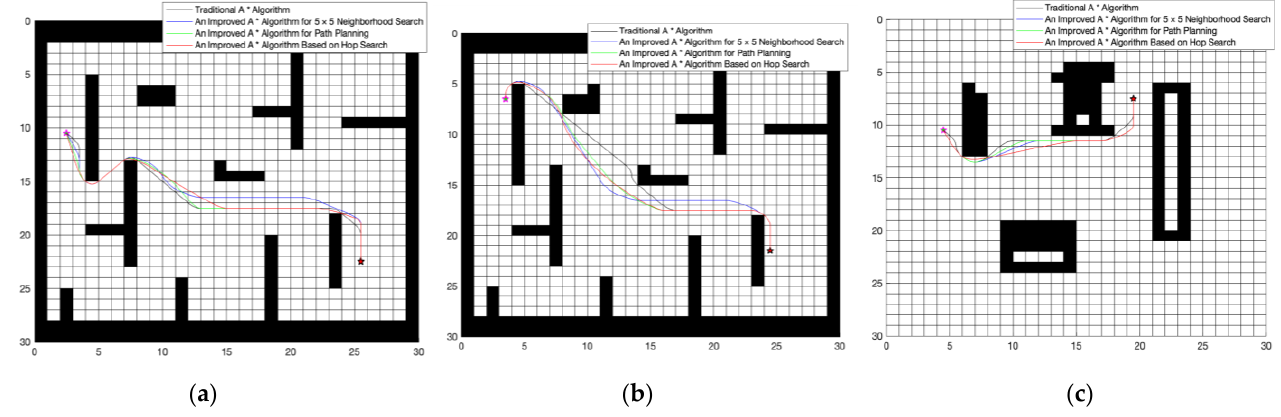
Figure 3. Path Planning Trajectories of Four Algorithms: ( a ) Path planning of four algorithms in environment I; ( b ) Path planning of four algorithms in environment II; ( c ) Path planning of four algorithms in environment III.